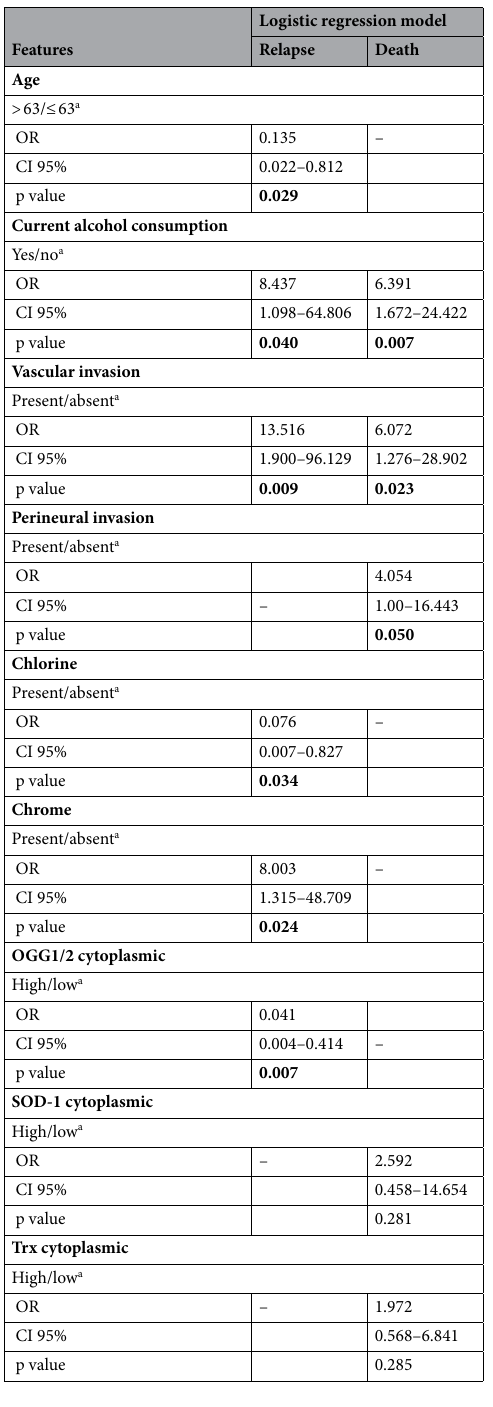
Table 1. Logistic regression model between prognostic, epidemiological and clinicopathological characteristics, trace elements and protein expression. OR odds ratio, CI confidence interval. Values in bold represent p < 0.05. a Reference